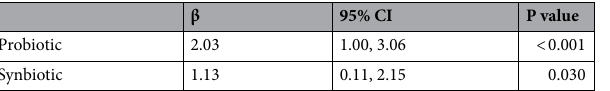
Table 3. Infant weight gain from discharge to study completion in Probiotic and Synbiotic Groups vs, placebo after adjustment for age during discharge from hospital, sex, WAZ during discharge from hospital.